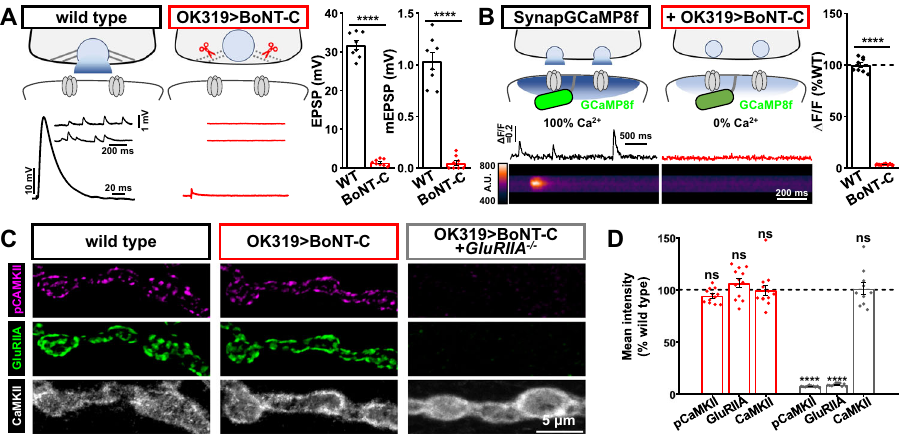
Fig. 3 | CaMKII activity remains unchanged when synaptic transmission is silencedbyBoNT-C.A SchematicdepictingcleavageofthesynapticvesicleSNARE complex by BONT-C expression ( w ; OK319-Gal4 / + ; UAS-BoNT-C /+), preventing all vesicle fusion. Representative electrophysiological traces and quanti fi cations are shownfortheindicatedgenotype,con fi rmingnoevokedorminiaturetransmission at NMJs silenced by BoNT-C. Quanti fi cation of average mEPSP amplitude ( B ), EPSP amplitude ( C ), and quantal content ( D ) values in the indicated genotypes (wild type: n =8; OK319>BoNT-C, n =8, p <0.0001 for mEPSP, p <0.0001 for